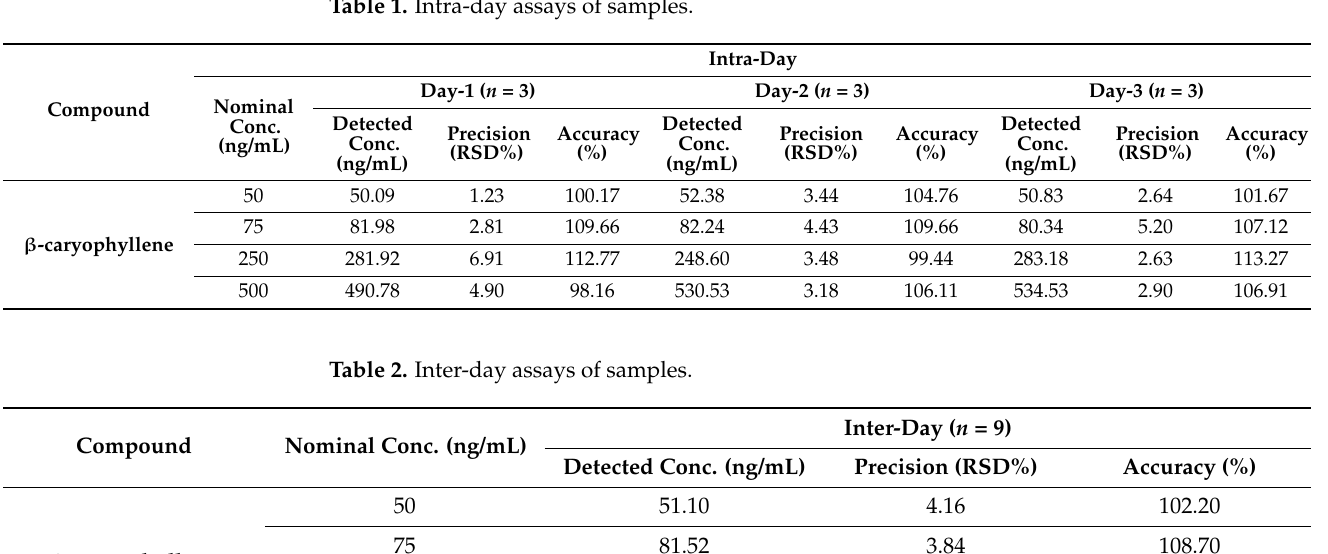
Table 1. Intra-day assays of samples.